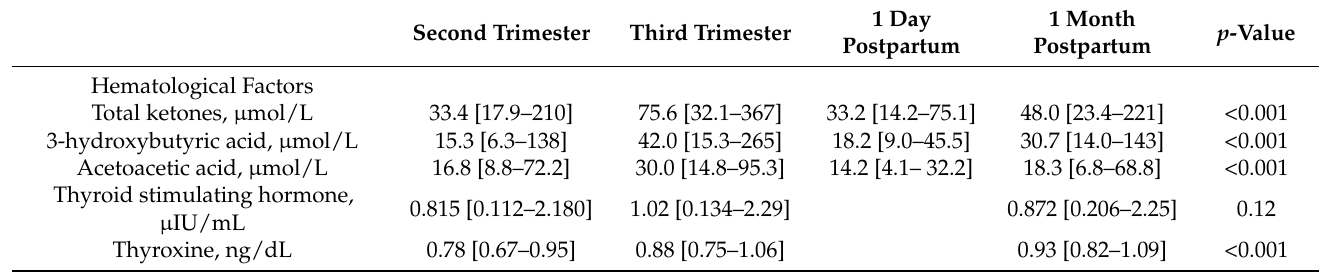
Table 2. Hematological factors of 99 pregnant women included in the